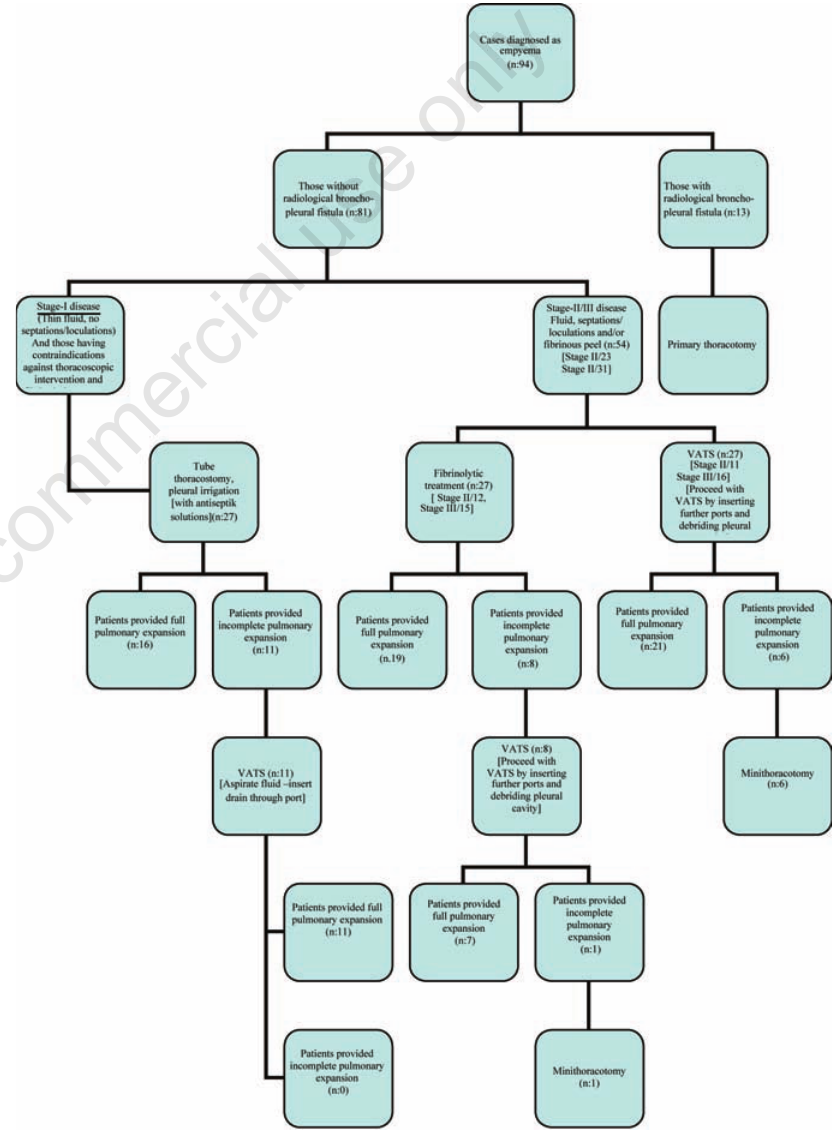
Figure 1. Treatment algorithm applied in children with